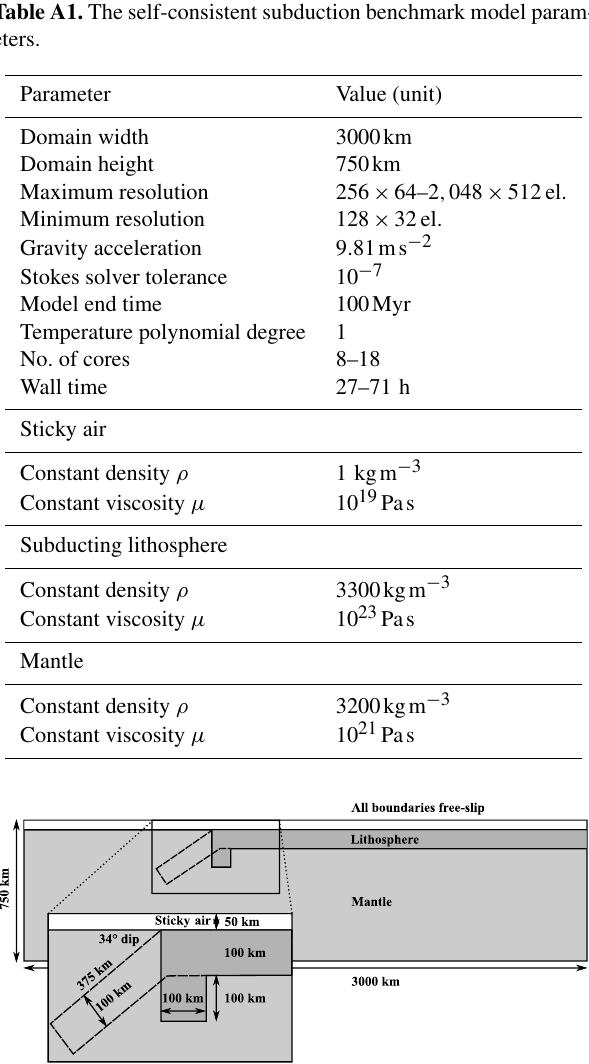
Figure A1. The self-consistent subduction benchmark model setup. The mantle, subducting plate and sticky air are represented by three compositional fields of constant viscosity. The slab geometry of case 1 is indicated in solid lines; the dashed line outlines the slab tip of case 2 (based on case 3 of Schmeling et al.,